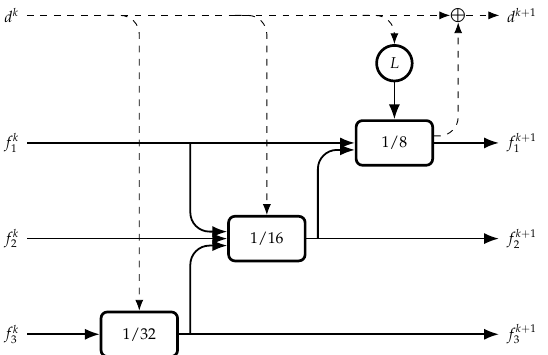
Figure 1. The multi-scale GRU shown with 3 feature maps f 1 , f 2 , f 3 at different scales 1/8,1/16,1/32. The disparity map d k shown is updated by adding the output of the lowest scale GRU 1/8, the correlation-pyramid lookup operation is shown as L and the result is inputted in the lowest scale GRU 1/8. Downsampling and upsampling are used to change the scales of the feature maps or disparity map when being passed between the GRUs.